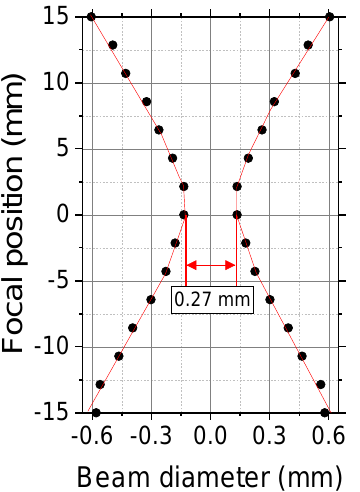
Figure 2. Measured laser beam profile. Mechanical and metallurgical tests were performed on the welded specimens. After laser welding, three tensile-test specimens were machined based on the ISO 4136 standard for each condition (Figure 3) and the static tensile tests were carried out at a head speed of 1 mm/min (Shimadzu, Kyoto, Japan). The welded specimen was polished and etched with 3% nital solution (3 mL HNO 3 and 100 mL ethanol) and the microstructure was observed by optical microscopy (OM, Olympus, Kyoto, Japan) and field-emission scanning electron microscopy (FE-SEM, Thermo Fisher Scientific, Waltham, MA, USA). The micro-Vickers hardness (Matsuzawa, Akita, Japan) was measured on the cross-section with an indent spacing of 0.1 mm along the specimen centerline, according to the ASTM E384-99 standard; the applied load and holding time for hardness measurement were 1.96 N and 10 s, respectively.